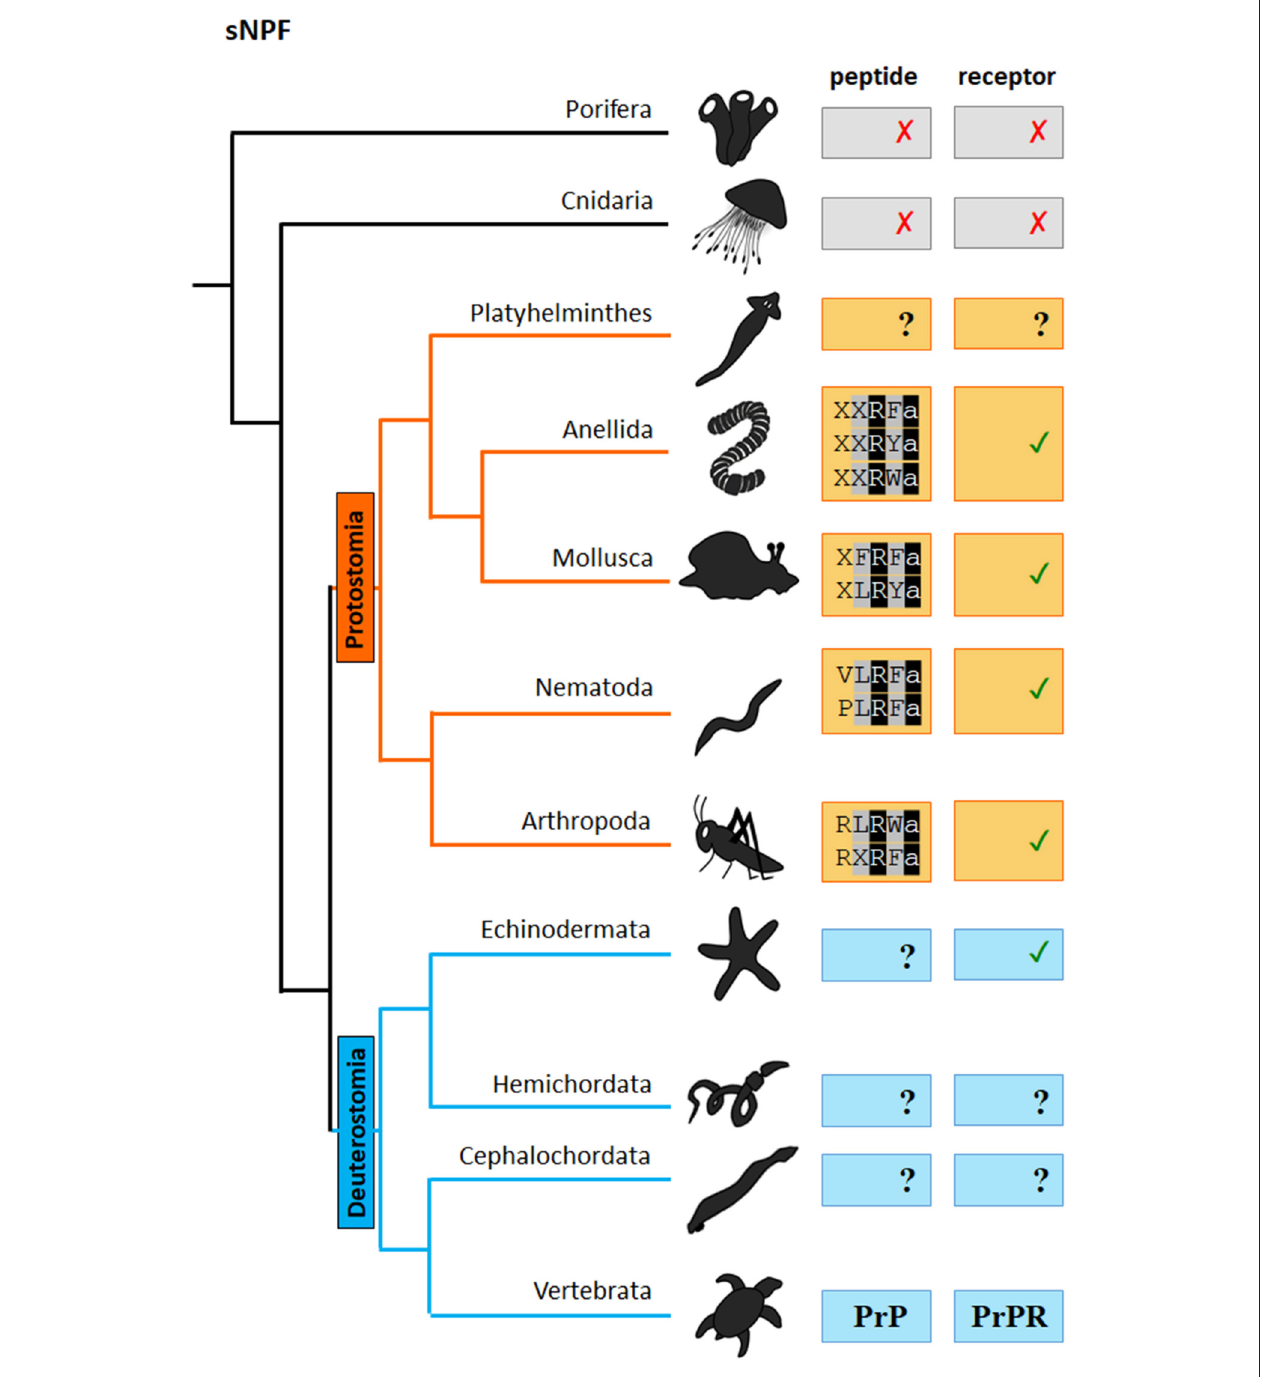
FIGURE 2 | Scheme of the presence of sNPF neuropeptides and receptors in distinct phyla of the metazoan evolutionary tree. “ X “ and “ 7 ” respectively represent the presence or absence of the peptide/receptor in the corresponding phylum. “ ? ” indicates that the presence of the peptide/receptor is not clear or has so far not been investigated. PrP: prolactin. PrPR: prolactin receptor. The sNPF sequence motif is indicated. The first X in the Annelida peptide motif represents a hydrophobic amino acid, while the second X indicates a Phe, Leu or Met amino acid residue. The X in the Mollusca peptide motif represents a hydrophobic amino acid. The X in the Arthropoda peptide motif represents a Leu or Ile amino acid